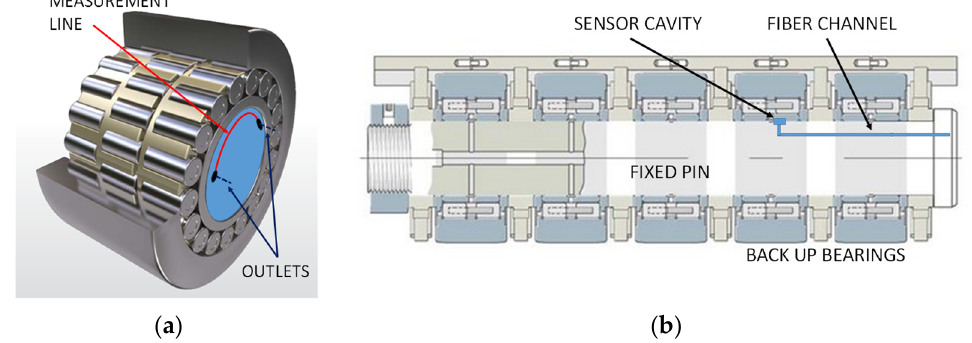
Figure 5. Example of location of sensors for pressure ( a ) and temperature ( b ) measurement in the backup bearing of a cluster cold rolling mill drawn upon rendering of bearing [61] and assembly [63].